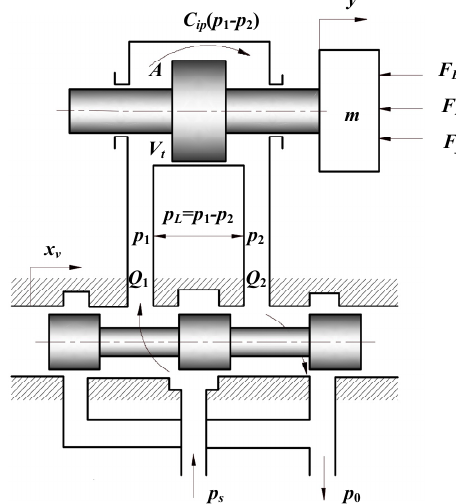
Figure 6. Valve-controlled hydraulic cylinder model .